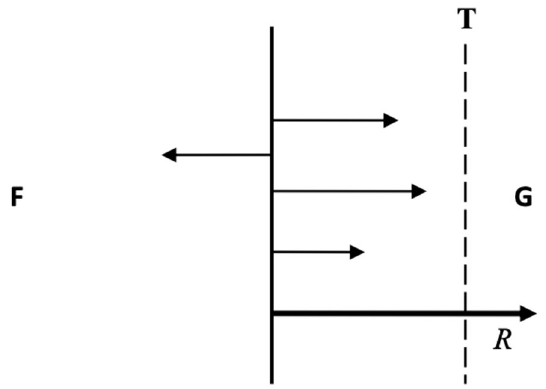
Figure 1. Powers Modelled as Vectors (Mumford and Anjum 2010, p. 145).